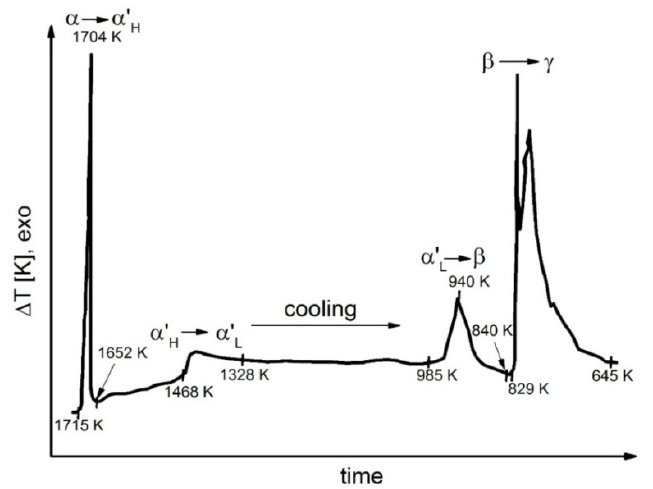
Figure 6. Thermogram recorded for sample 1 during the cooling process.